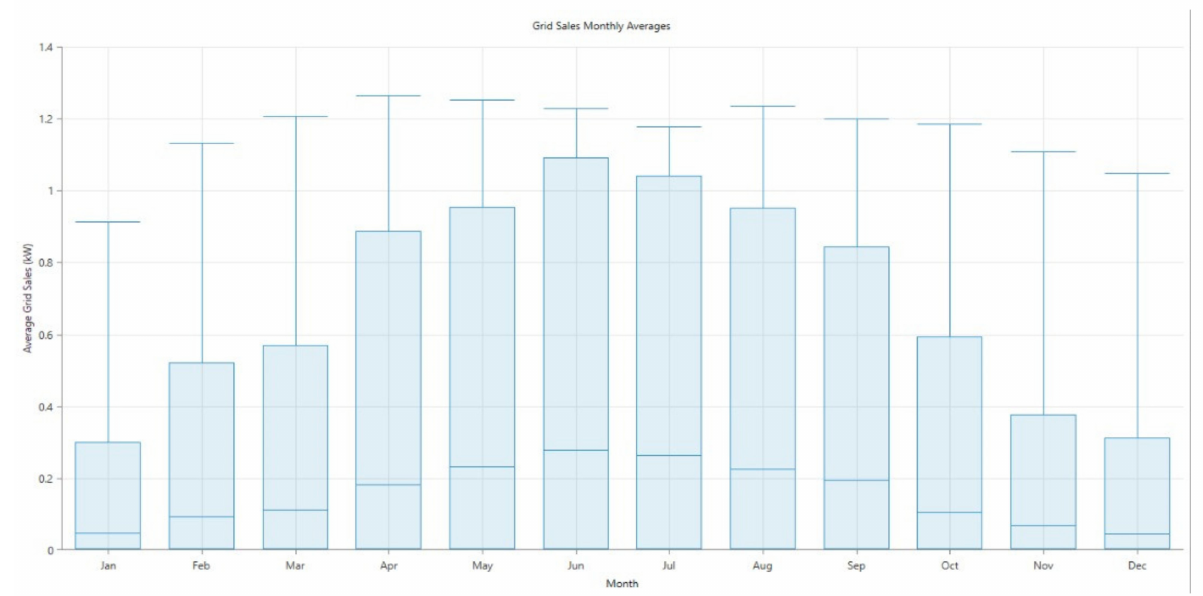
Figure 17. Monthly electricity production in one year in